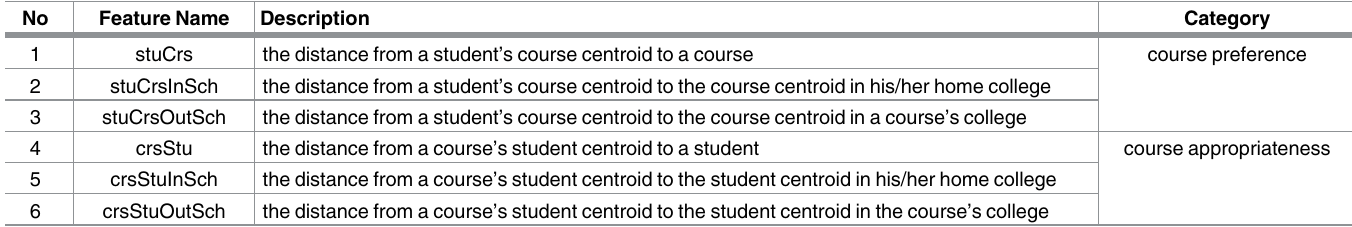
Table 4. Definitions of the graph-based